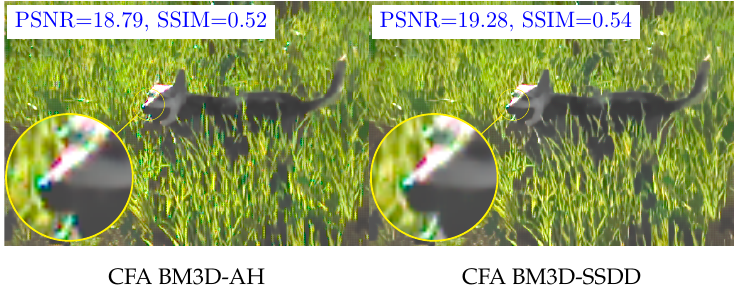
Figure 16. Filtering results for dog test image—ISO